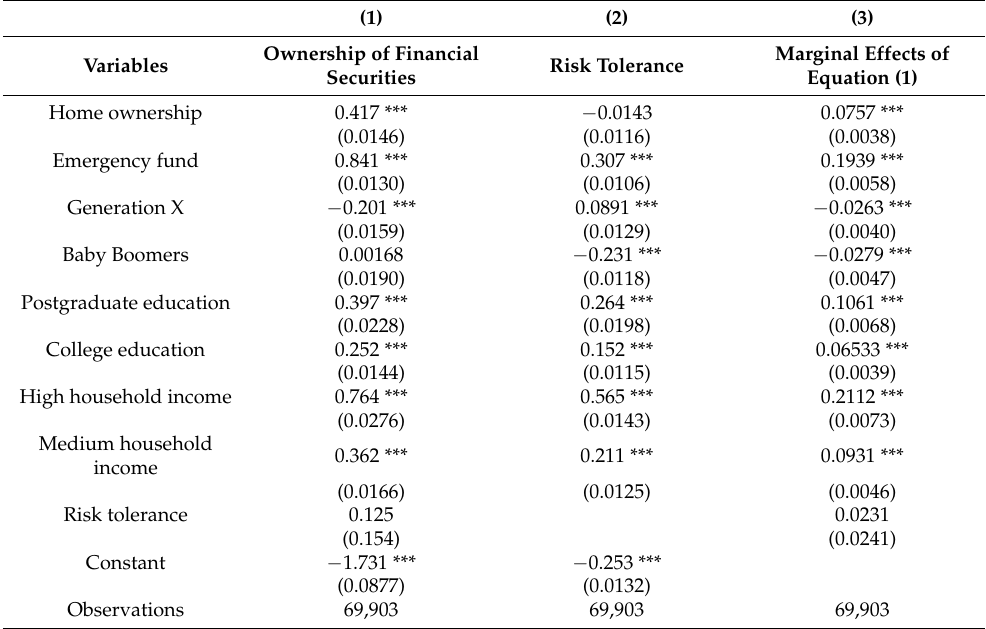
Table 4. Estimation of bivariate probit